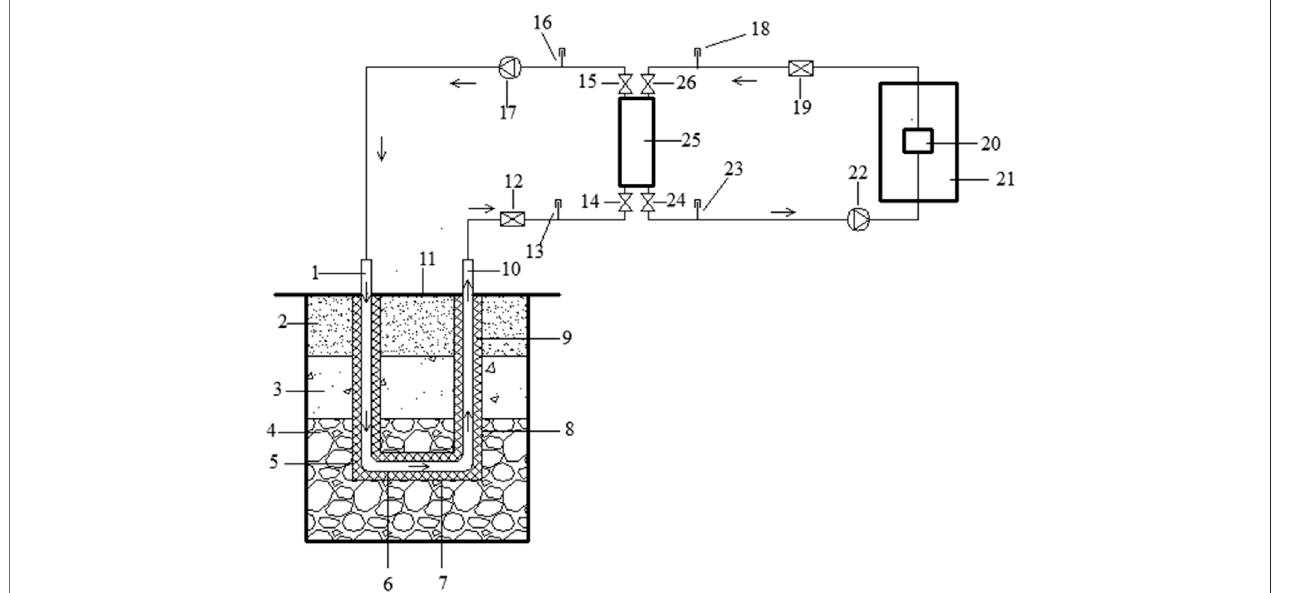
FIGURE 2 | Diagram of the GSHP system employing the U-type medium-deep.